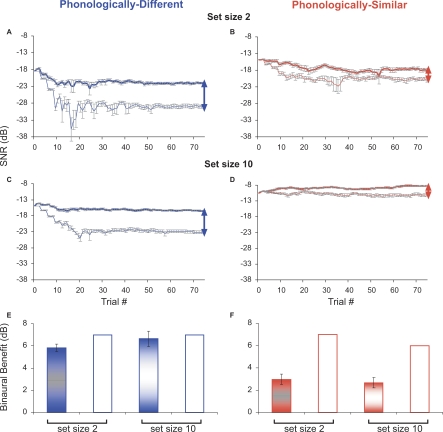
Results of Study 2, Experiments ILeft: results using phonologically different words (blue). Right: results using phonologically similar words (red).(A–D) The dynamics of the adaptive threshold assessment as a function of trial number (averaged across subjects ± SEM, n = 25). Notations as in Figure 1. Vertical arrows denote binaural benefits. All measurements were done using the mixed binaural protocol. (A and B) An identification task using a set size of two words.(C and D) An identification task using a set size of ten words.(E and F) A summary of the average binaural benefits obtained in the experiment (filled shaded bars) and the benefits calculated by the ideal listener model (open bars; see Figure S3), for the set size 2 and set size 10 conditions.